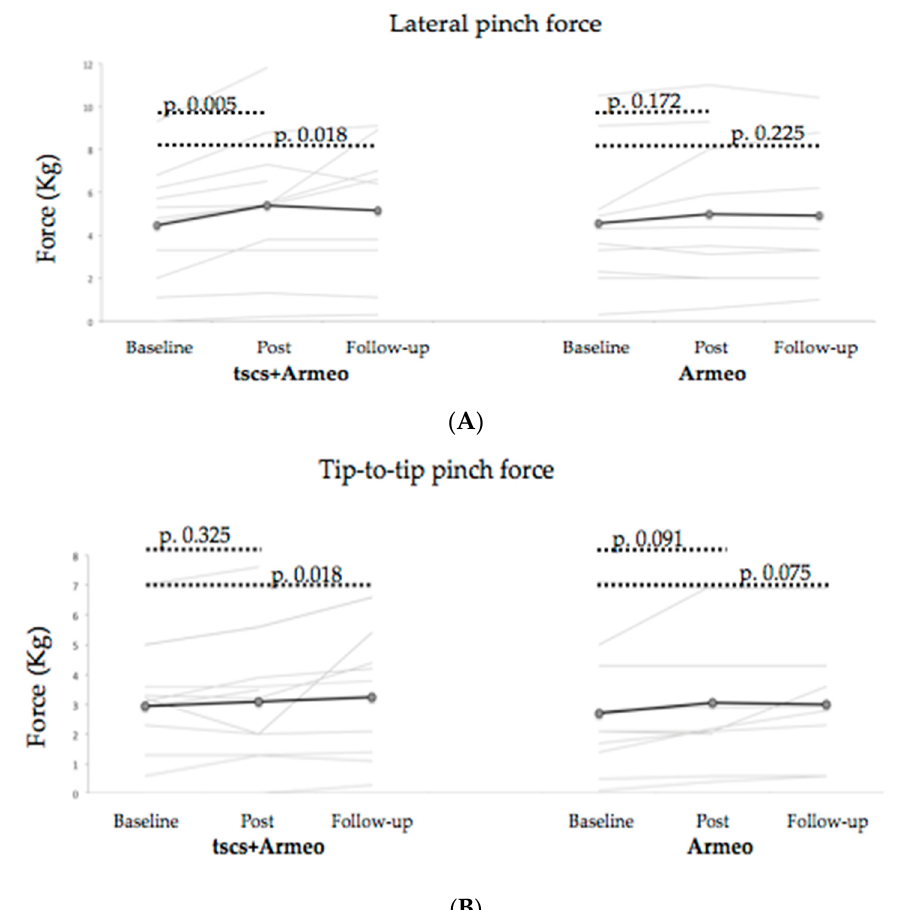
Figure 4. ( A ): Lateral pinch force score. The p -value according to the Wilcoxon test; ( B ): Tip-to-tip pinch force. The p -value according to the Wilcoxon